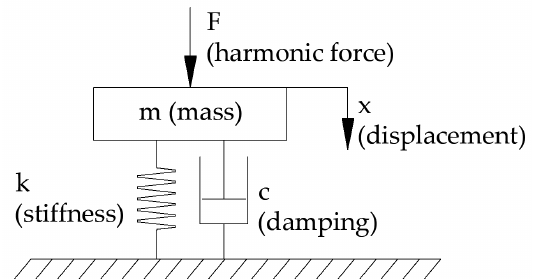
Figure 3. Physical model of the mass–damper–spring system with one degree of freedom. Measurement of system response in the form of accelerations was recorded using an IEPE accelerometer-MMF KS78B.100 placed on a pressure plate. Control force measure- ment was performed using a Force sensor—Forsentek FSSM 50 N placed between an ex- citer piston and a pressure plate.